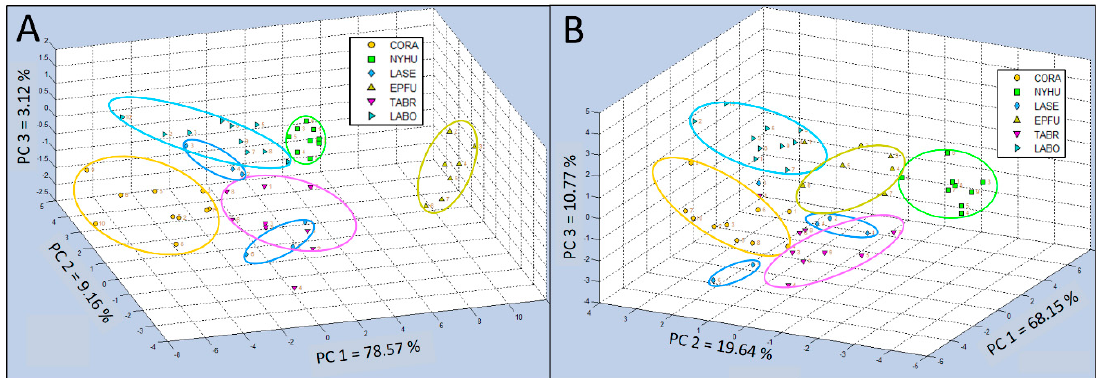
Figure 5. Comparison of C-320 e-nose VOC profiles of bat air samples from six species (Test Group 1) using 3-dimensional Principal Component Analysis (PCA) and Canonical Discriminant Analysis Cross Validation (CDA-CV). ( A ) Single-class PCA of VOC emissions from Corynorhinus rafinesquii (CORA), Nycticeius humeralis (NYHU), Lasiurus seminolus (LASE), Eptesicus fuscus (EPFU), Tadarida brasiliensis (TABR), and Lasiurus borealis (LABO); ( B ) CDA-CV of VOC emissions from the same six bat species in Test Group 1.